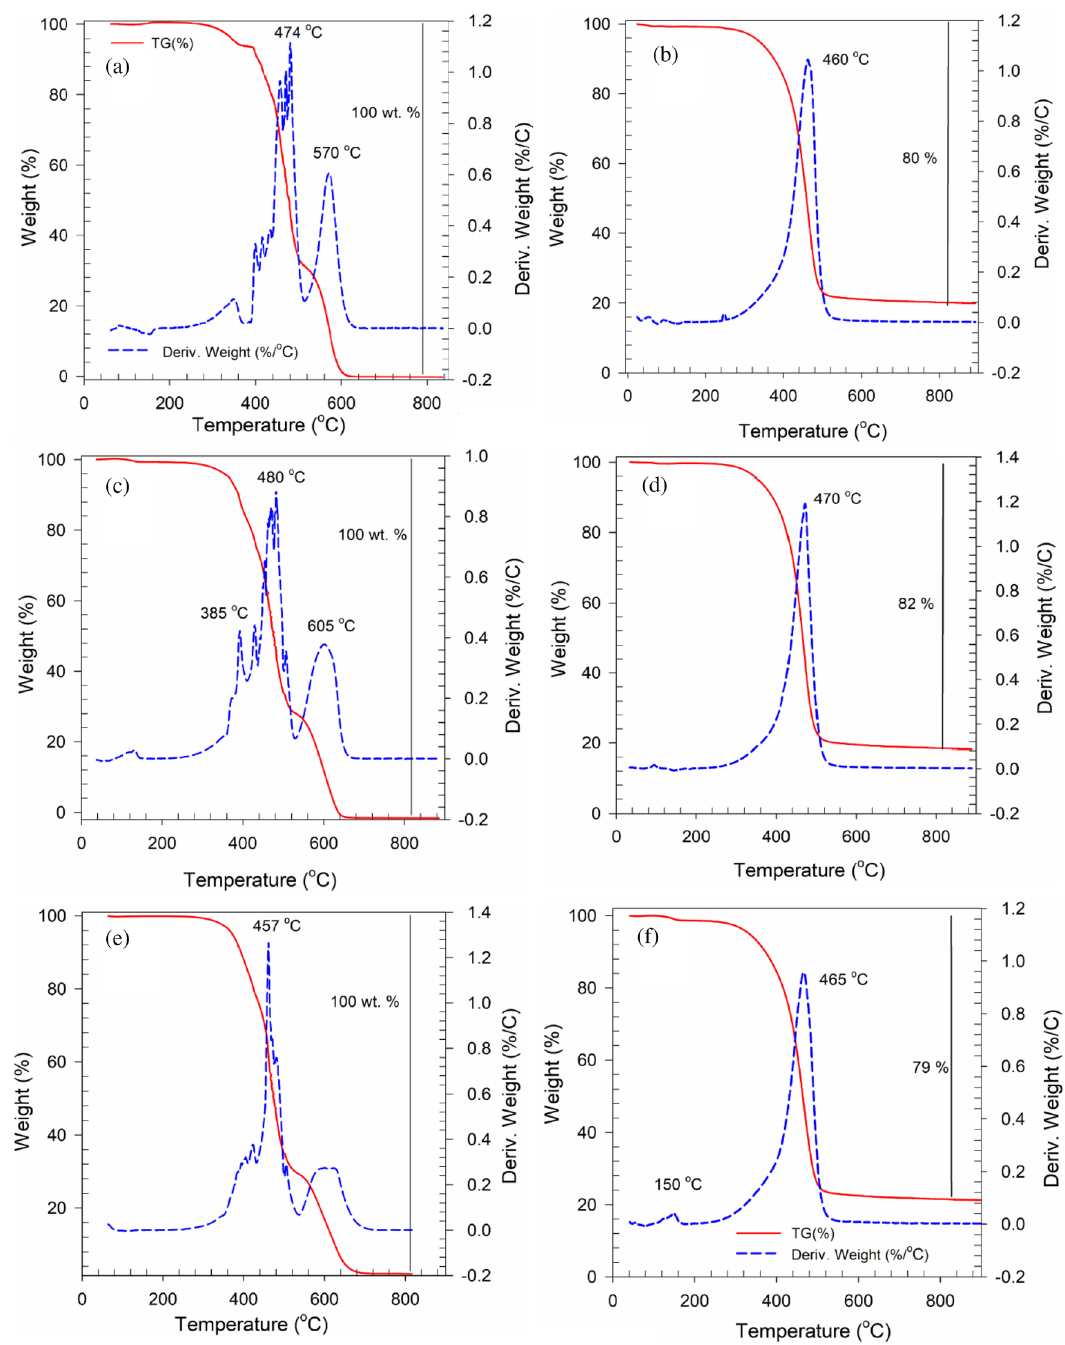
Figure 5. Thermal Gravimetric Analysis (TGA) and Derivative Thermo-Gravimetry (DTG) curve: ( a ) unaged binder, ( b ) unaged binder modified by FSN, ( c ) short-term aged binder, ( d ) FSN-modified binder after short- term aging, ( e ) long-term aged binder, and ( f ) FSN-modified binder after long-term